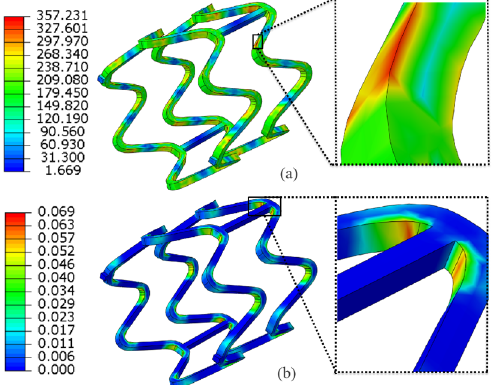
Figure 8. Variation of stress and strain at some points of L-type coronary stent during compression stage.